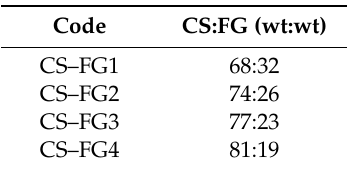
Table 1. Three-dimensional printing